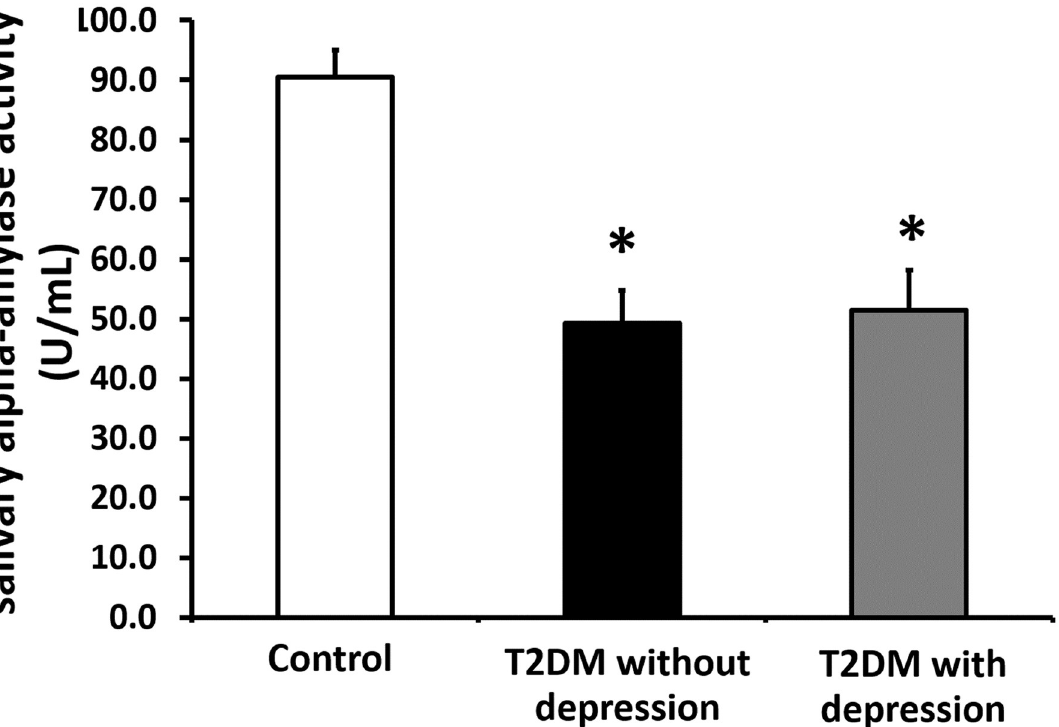
Fig 2. Effect of depression on salivary alpha-amylase activity in T2DM patients. � p < 0.05 vs. control group, T2DM = Type 2 diabetes.